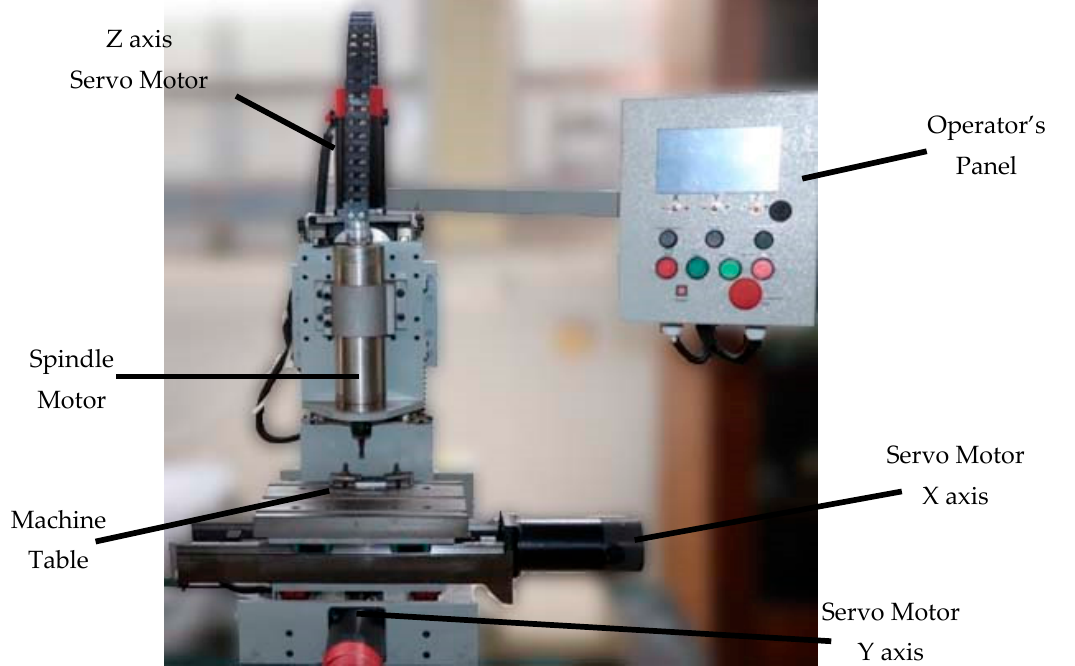
Figure 1. Overall view of the developed CNC machine.